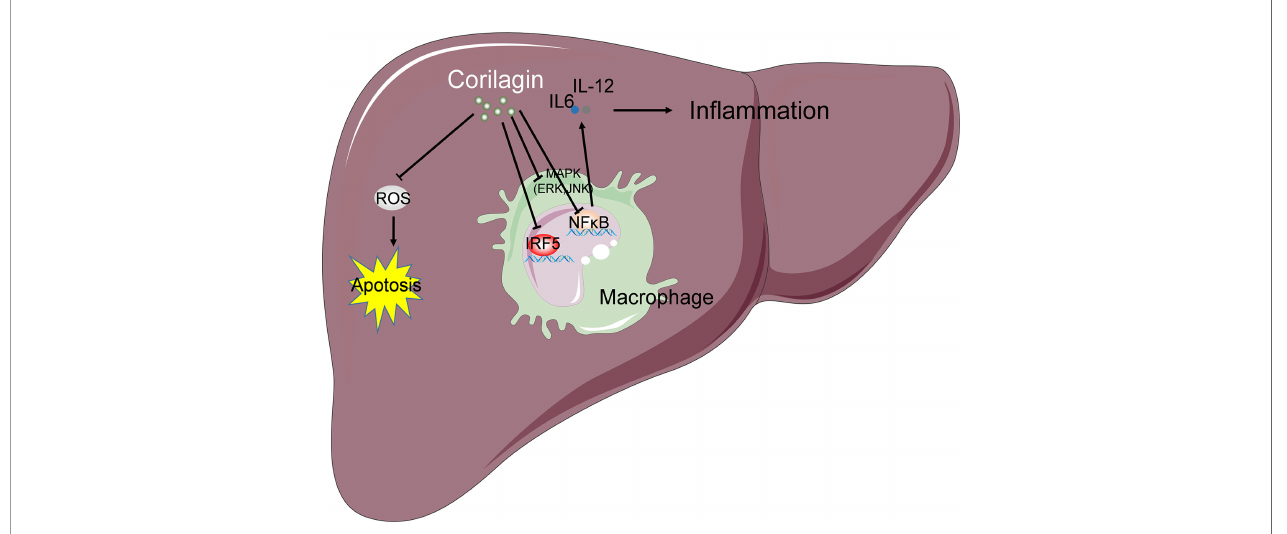
FIGURE 7 | Schematic summary of possible mechanism underlying the protective effects of corilagin on Con A induced liver injury. The mechanism is associated with the inhibition of corilagin on the activation of M1 macrophage via MAPK, NF- k B, and IRF signaling pathways, resulting in the suppression of in fl ammation. Corilagin also attenuates Con A-induced oxidative stress and hepatocyte apoptosis in the liver tissue. “ ! ” indicates promotion or positive regulation; “ ⊥ ” indicates inhibition or negative